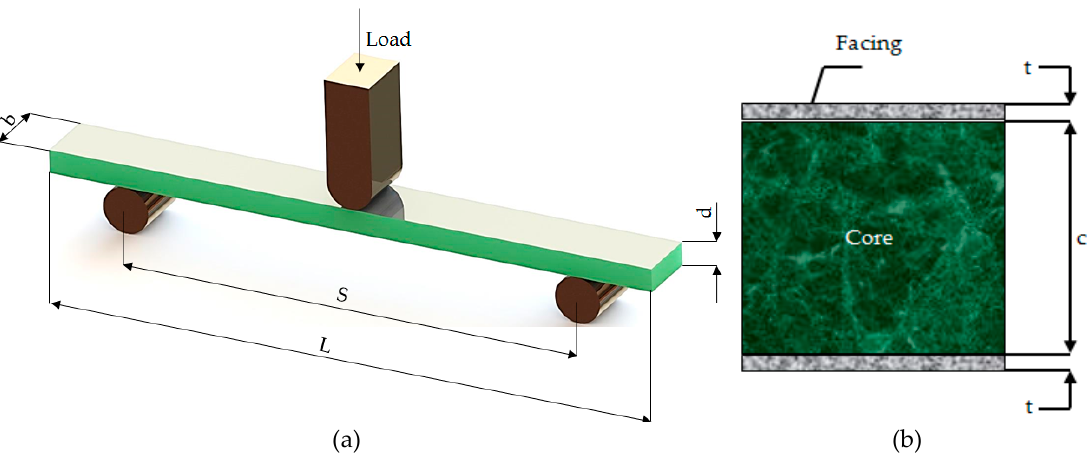
Figure 2. Principle of the three-point bending test of the GFRP-foam specimens ( a ). Cross section of the GFRP-foam specimens ( b ).